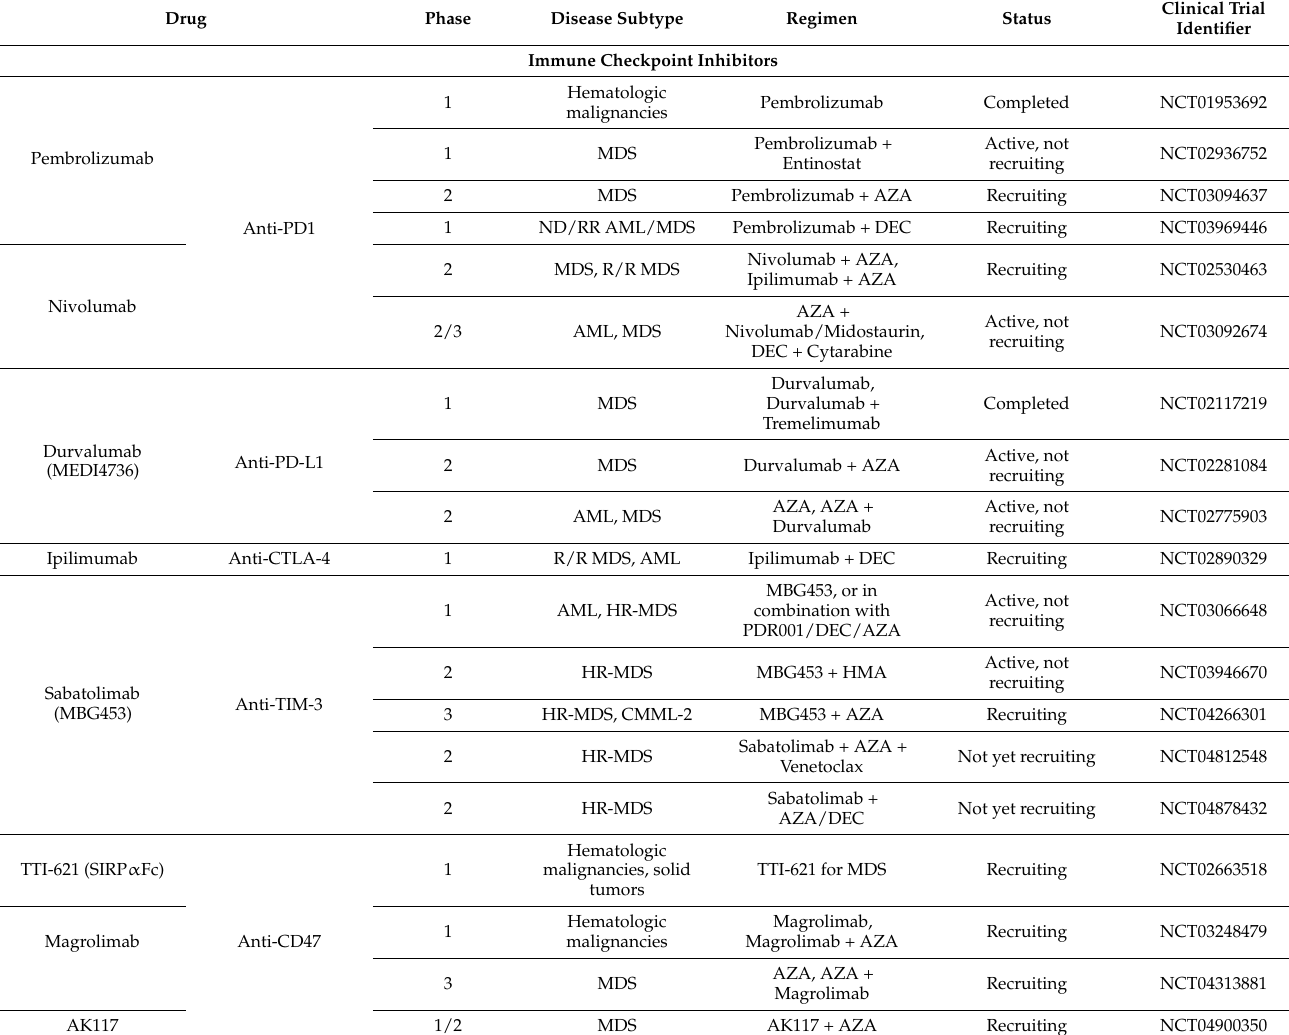
Abbreviations: ND, newly